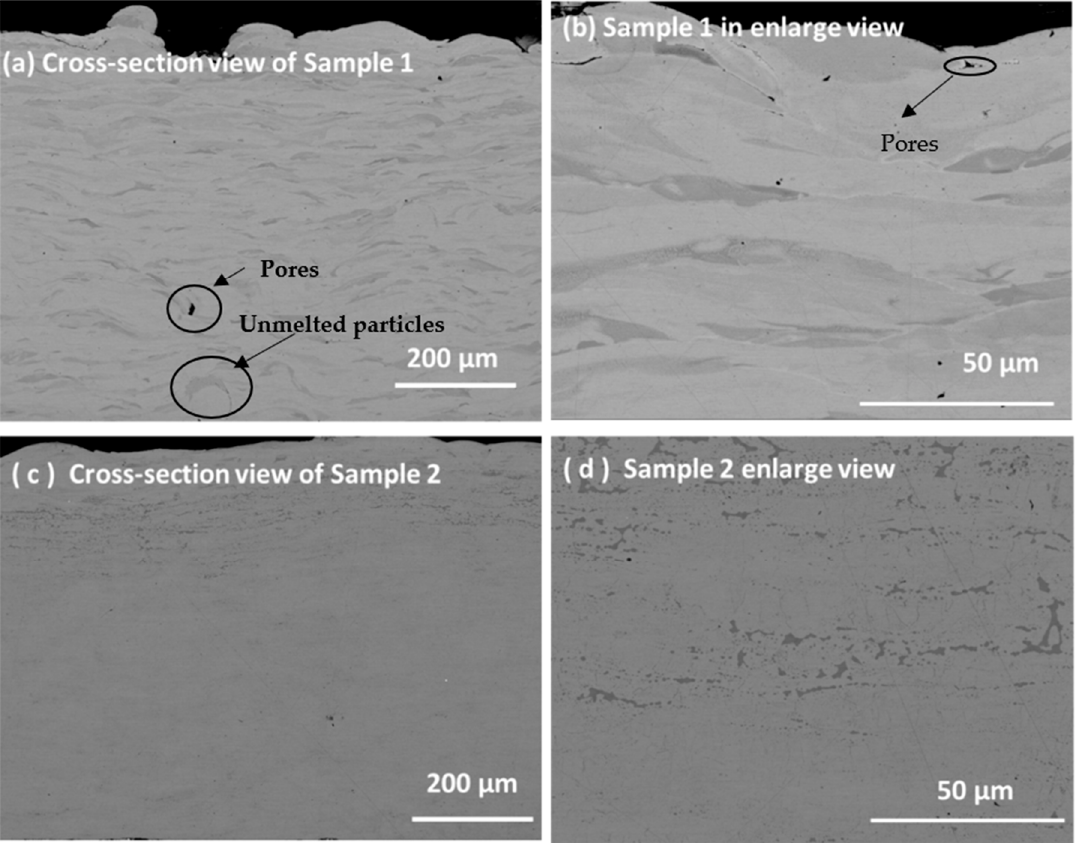
Figure 1. ( a – d ) The cross-sectional image of plasma spray samples 1 and 2 with enlarged view.